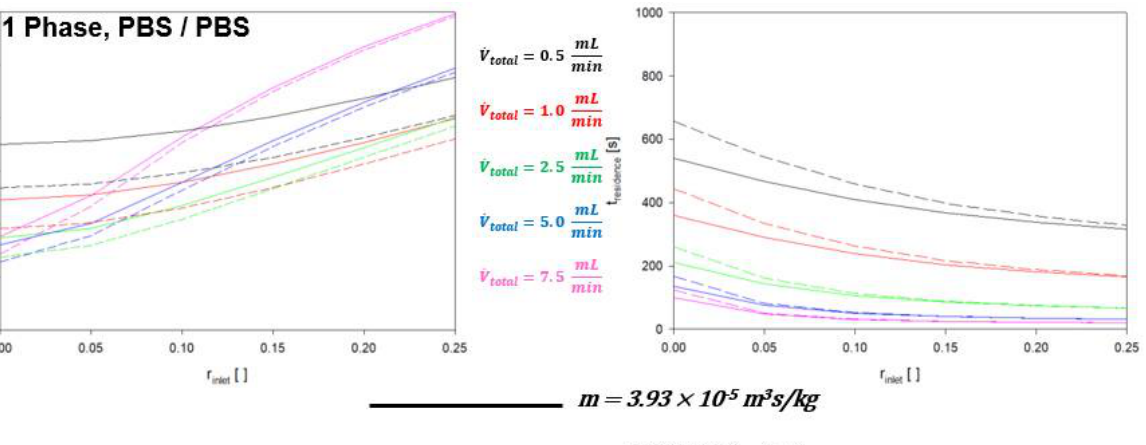
Figure 2. Simulated crossover for paramagnetic healthy RBCs and their expected residence times. Five throughputs are graphed with two mobilities each; the high (solid line) and low (dashed line) mobilities correlate to the 75th and 25th percentile for a typical healthy RBC sample. As RBCs age during ex vivo storage, they lose Hb through microvesiculation and exhibit lower mobility when converted into the deoxy or met state while some RBCs remain fully paramagnetic.